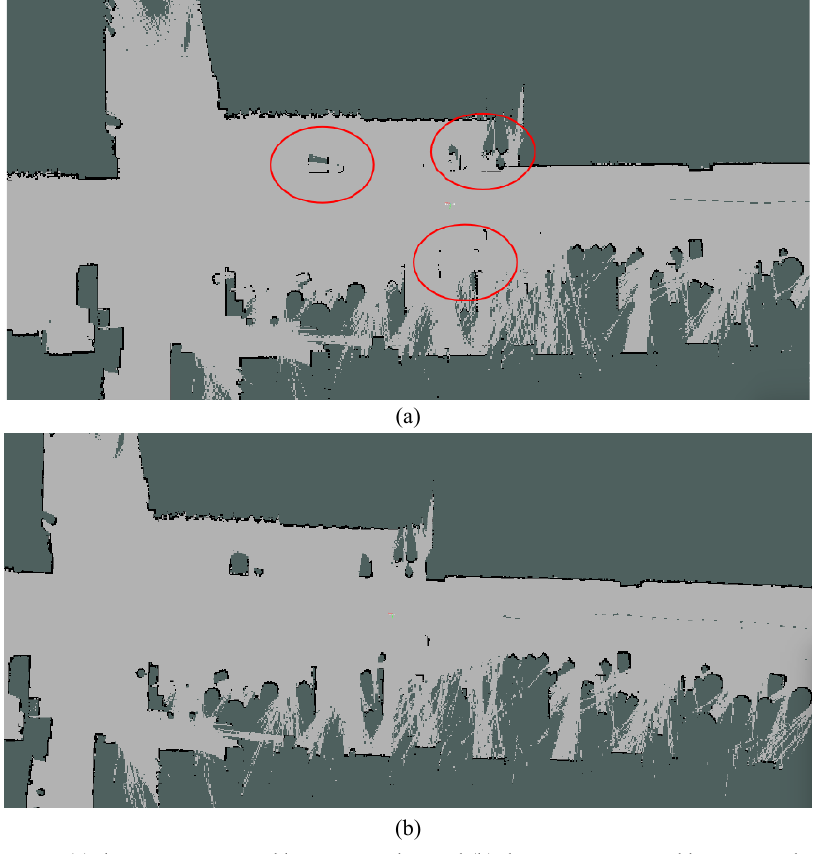
Fig. 16 Loop closure test: (a) the map constructed by cartographer and (b) the map constructed by proposed method.